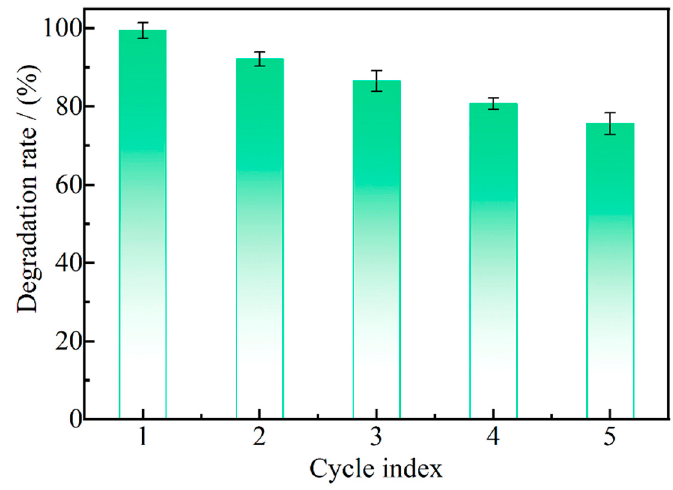
Figure 12. Experiment of stability.